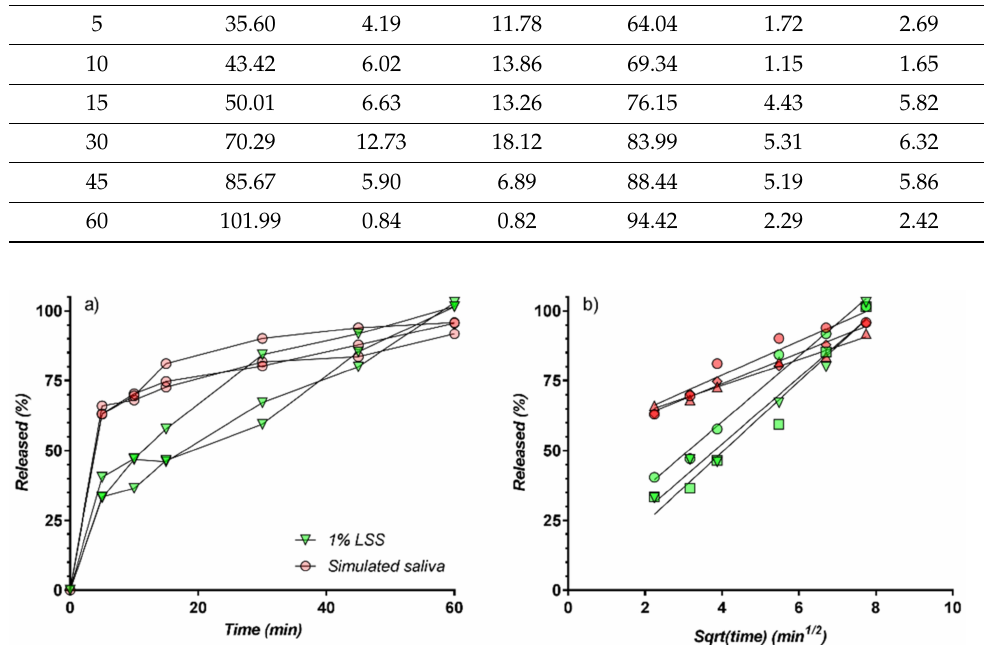
Figure 8. ( a ) Release curves from tablets; ( b ) release curves as function of square root of time.